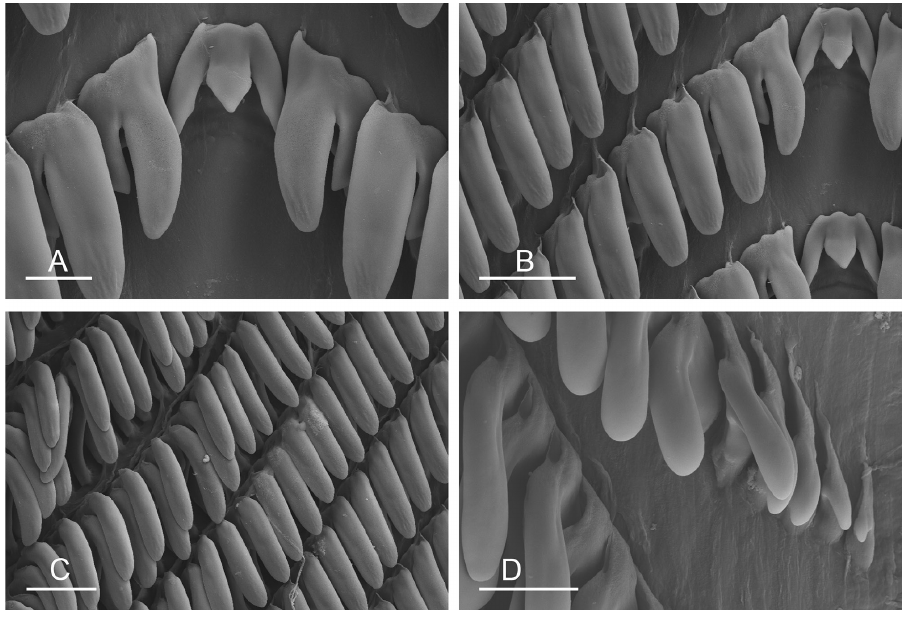
Figure 61. Radula, Wallaconchis melanesiensis , Indonesia ( A–C ) Halmahera [5132] (UMIZ 00069) (D) Ambon [2733] (UMIZ 00068). A Rachidian and innermost lateral teeth, scale bar 20 μm B Rachidian and inner left lateral teeth, scale bar 20 μm C Transition between inner lateral teeth and outer lateral teeth, scale bar 30 μm D Outermost lateral teeth, scale bar 20